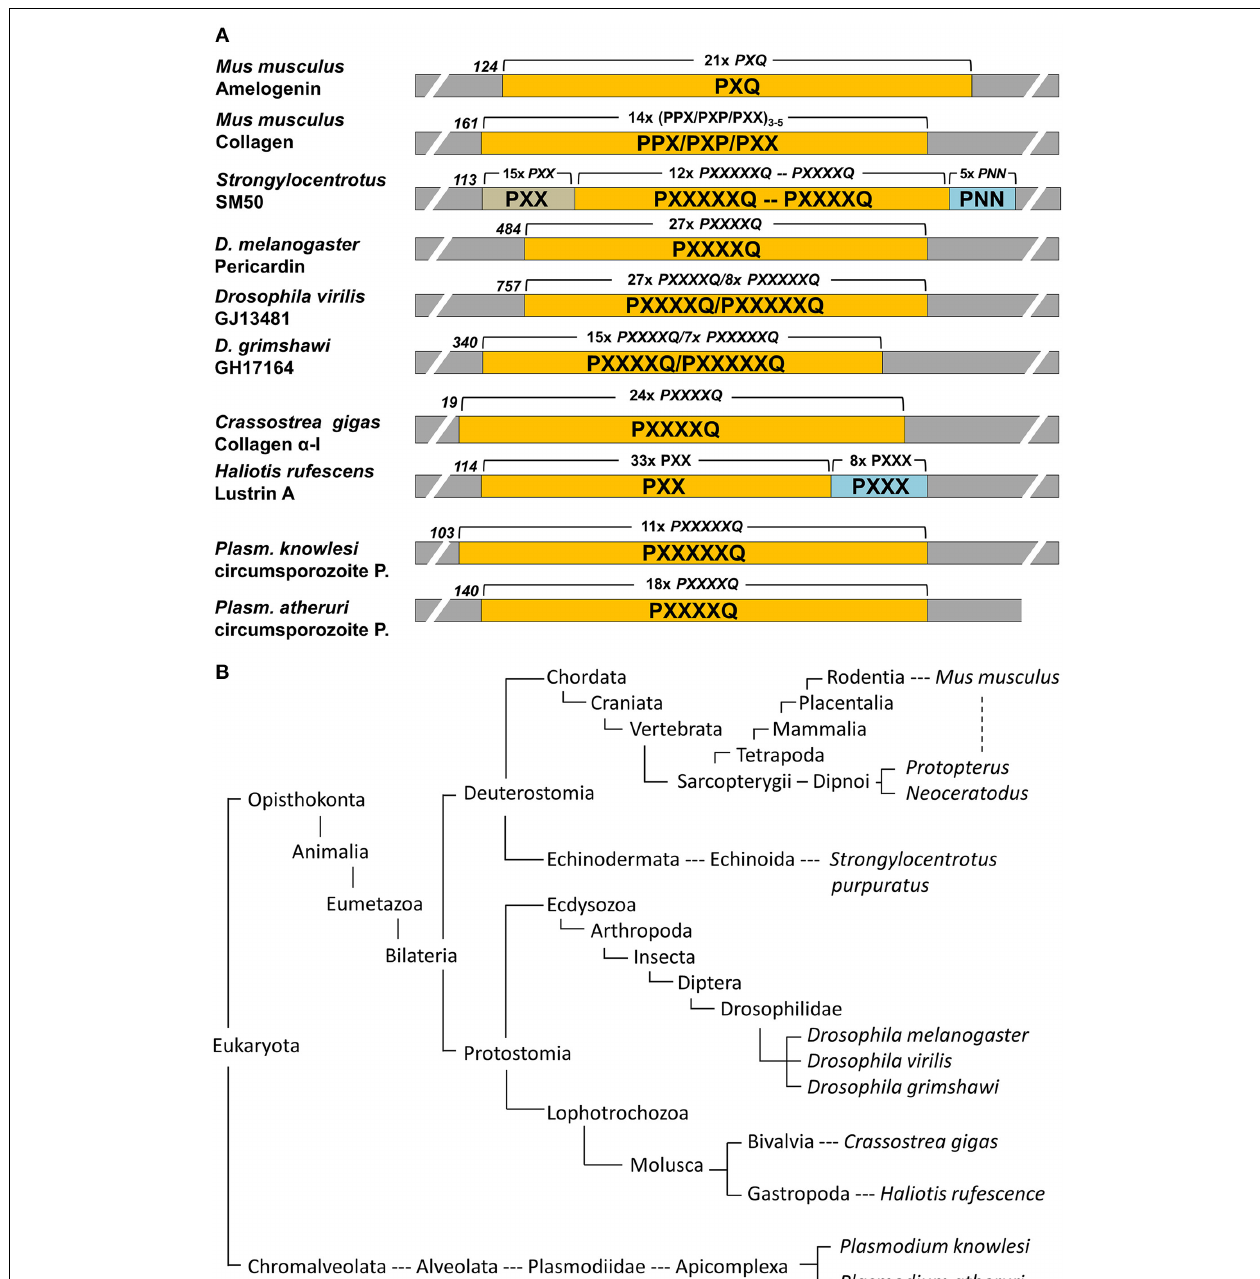
FIGURE 1 | Conservation of proline repeat elements among selected eukaryotic proteins as identified by BLAST searches. (A) illustrates the major proline repeat element composition, the N-terminal onset of the repeat region, and the number of repeats in selected eukaryotic repeat element containing proteins. P, proline; Q, glutamine; N, Asparagine; X, any amino acid. (B) Corresponding eukaryotic lineages to the repeat element